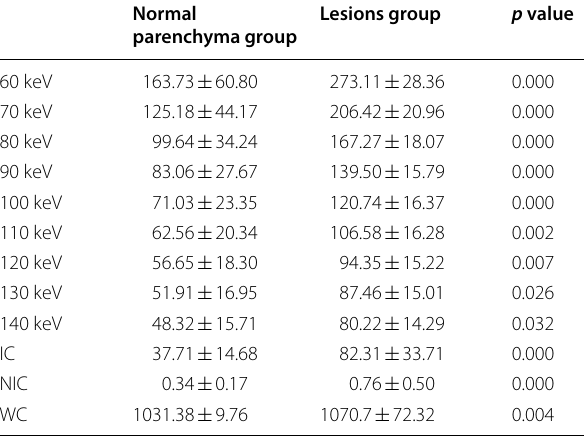
Table 5 Comparison of CT values of each single energy keV and IC, WC and NIC values in the arterial phase between normal pancreatic parenchyma group and the lesions group Normal Lesions group p value parenchyma group